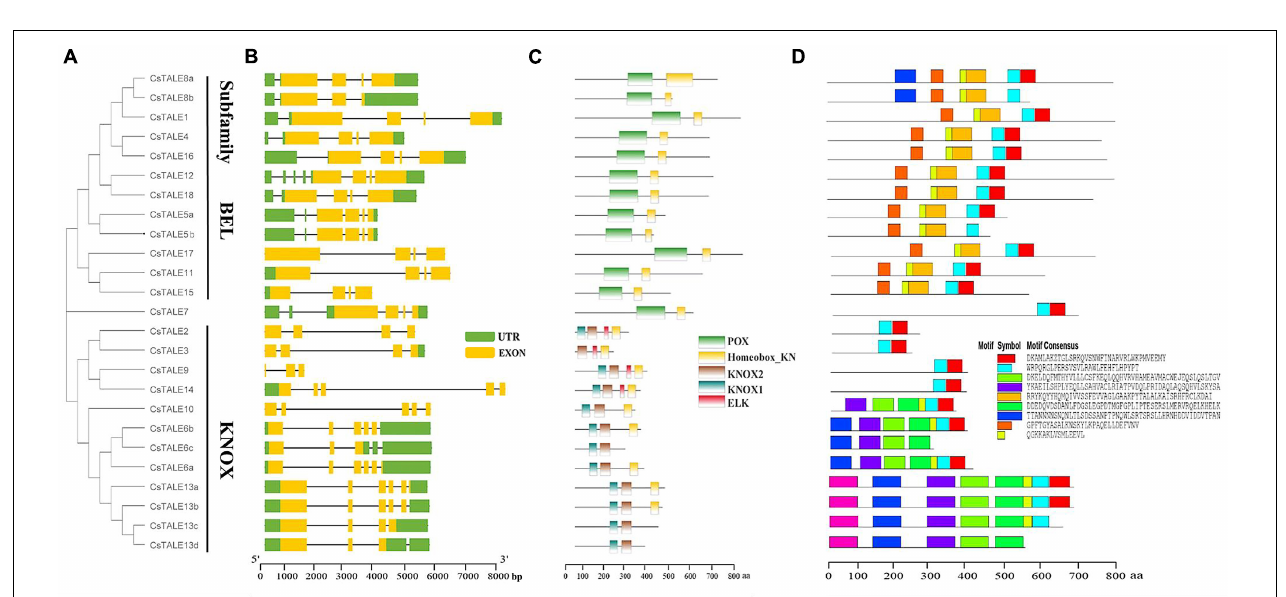
FIGURE 2 | Duplication events of CsTALE genes. (A) Circle plot displayed duplication events of CsTALE genes based on the sweet orange genome. Colored lines indicated duplication of CsTALE genes. (B) The homologous gene pairs between sweet orange and Arabidopsis. Gray lines indicate all the collinear blocks within sweet orange and Arabidopsis. Other colored lines indicate TALE homologous gene pairs.